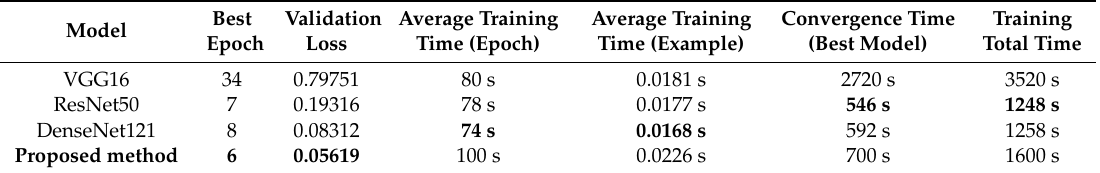
Table 4. Time measurement of network training.